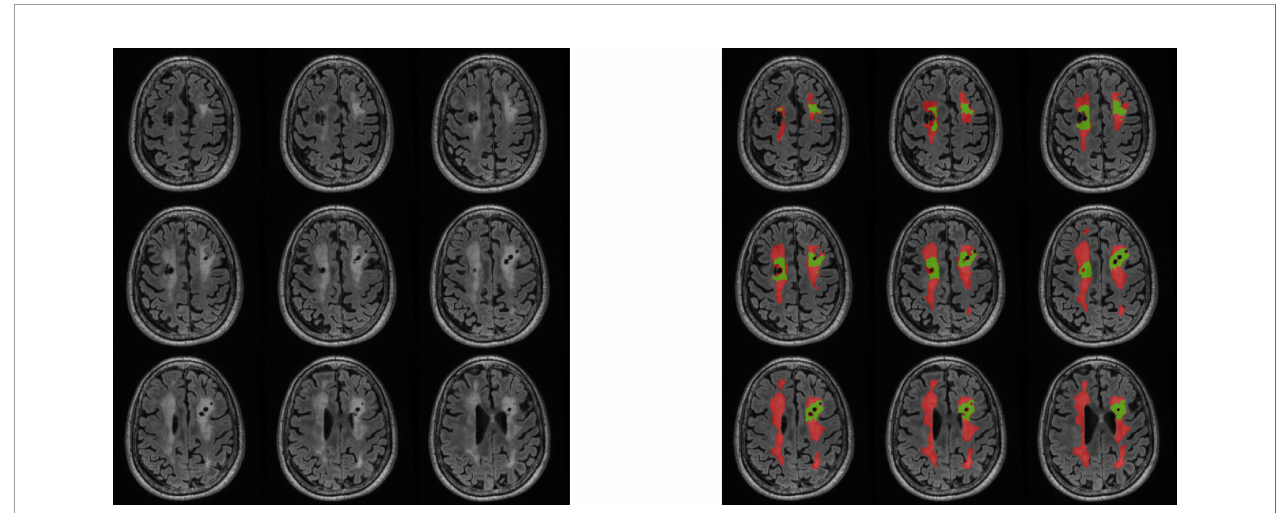
FIGURE 3 | Visual representation of WML analysis. Imaging inclusive of manual T2-FLAIR white matter lesion segmentations with RT-induced (red) and non-RT- induced (green) labeling. RT, radiation